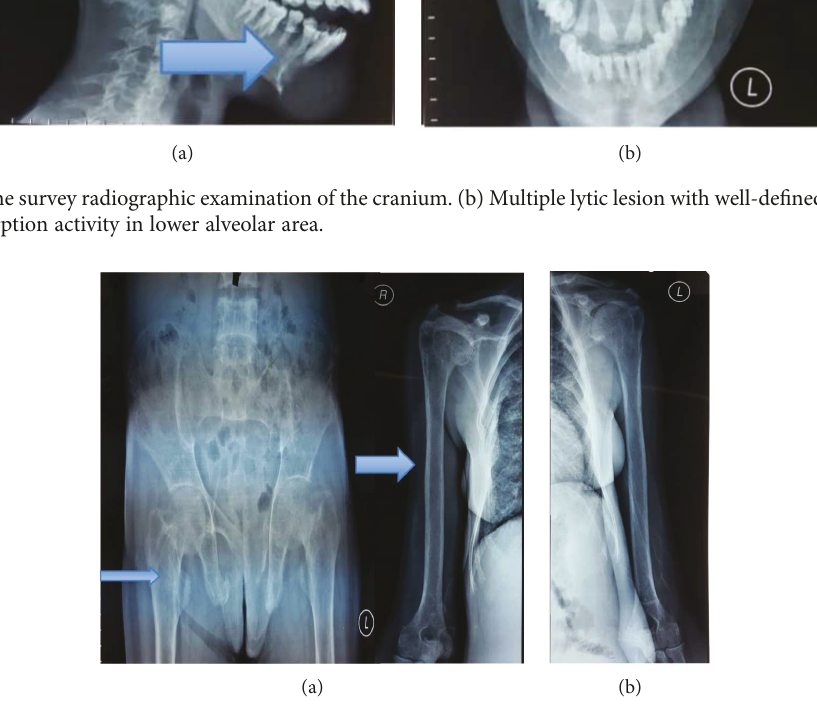
Figure 3: Case 1. Bone survey radiographic examination of the (a) pelvis showing multiple lytic lesion along the bilateral iliac bone and pubic bone and the (b) humerus and clavicle showing multiple lytic lesion along the lateral edge of the humerus. Pathologic fractures of the distal part of the left clavicle are observed, increased bone resorption among the bilateral